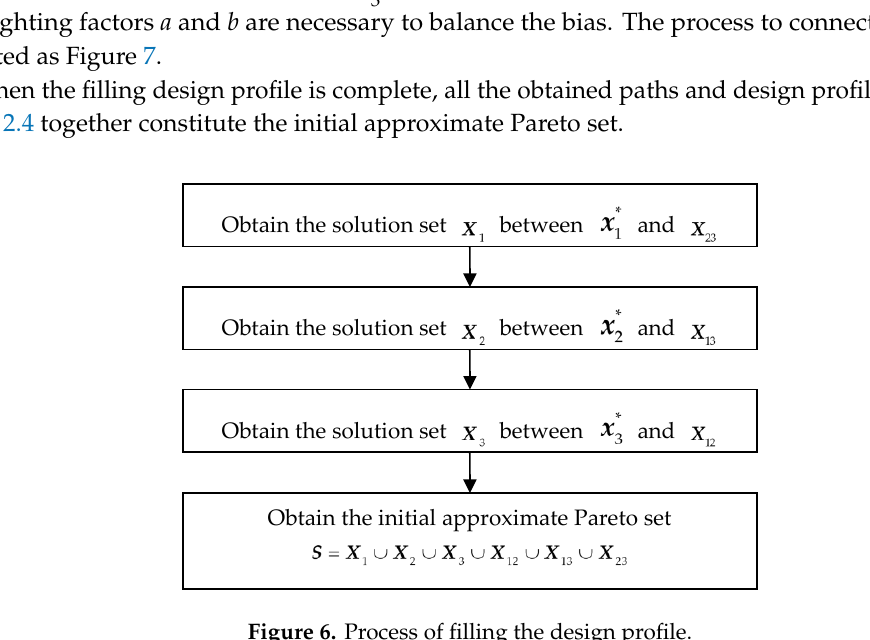
Figure 6. Process of filling the design profile.